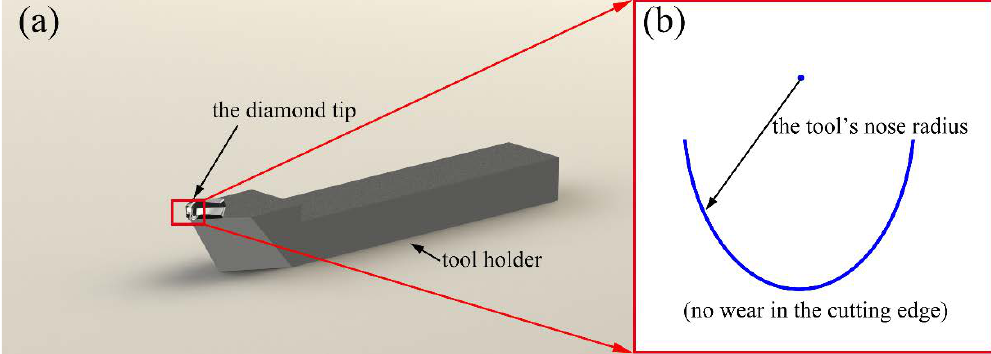
Figure 3. ( a ) The photograph of the used diamond tool, ( b ) the geometry of the diamond tool edge.